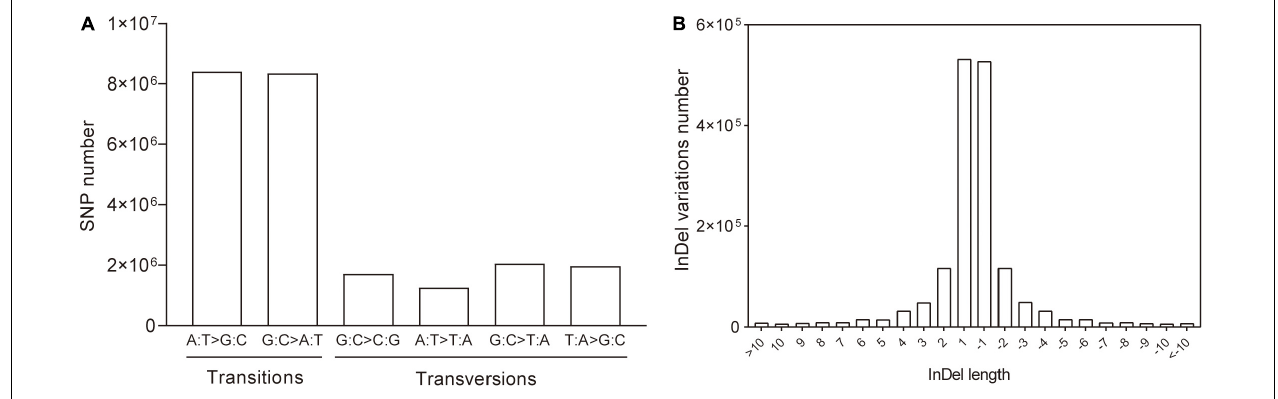
FIGURE 2 | Variation patterns of genomic SNPs and Indels in eh1 . (A) Numbers of specific types of SNPs in the whole genome of the gamma-ray-induced mutant eh1 . (B) Statistics of Indel size identified by genome resequencing. The positive and negative values represent insertions and deletions, respectively.